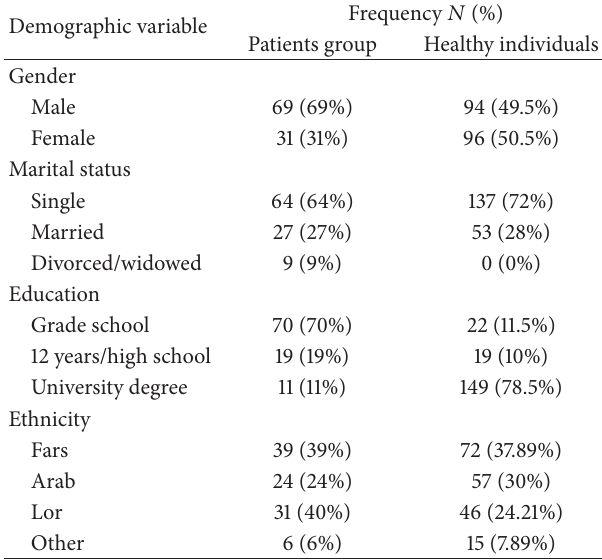
Table 1: Frequencies of the participants’ demographic